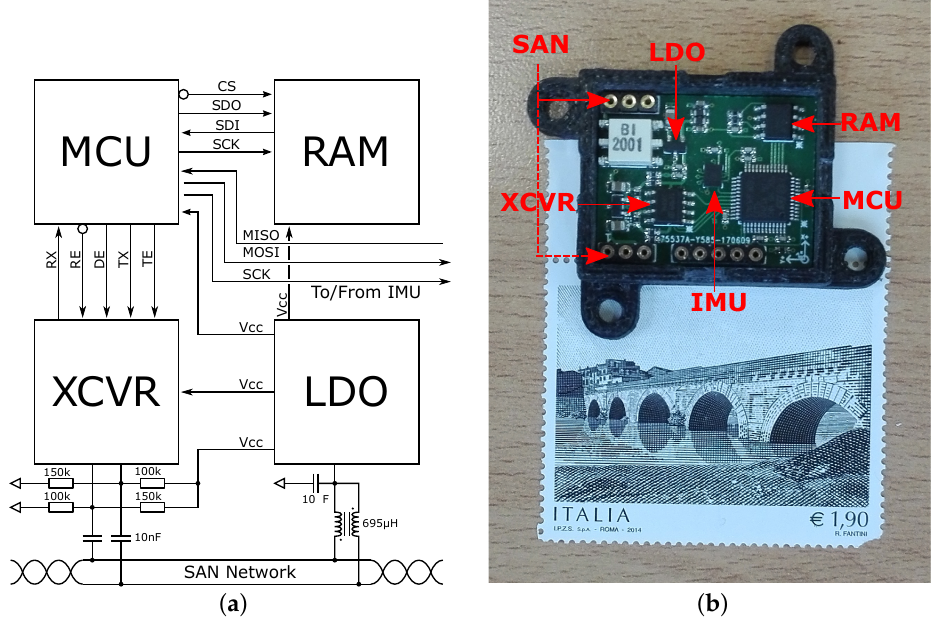
Figure 1. Hardware instrumentation: ( a ) Schematic diagram of the sensor node and ( b ) its relative prototype inside an ad-hoc